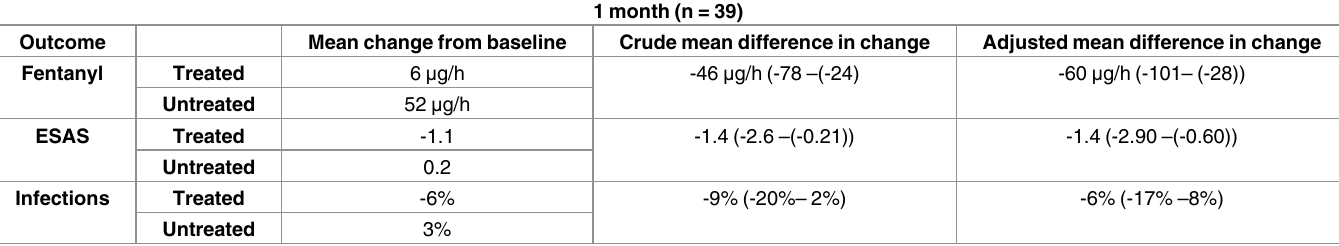
Opioid dose At baseline there was no statistically significant difference in opioid doses between the groups. The mean fentanyl dose in the vitamin D treated patients was 31 μg/h at inclusion (n = 39), 37μg/h after one month (n = 39) and 22 μg/h after three months (n = 26). In the control group the mean fentanyl dose increased from 43 μg/h at baseline (n = 39), to 95 μg/h after one month (n = 39), and 117 μg/h (n = 26) after three months observation time. The change in fentanyl dose between the groups was analyzed by linear regression with bias corrected and accelerated bootstrap and revealed a statistically significant difference already Table 2. Results from crude and adjusted analysis of change in fentanyl dose, ESAS QoL-score and infections (% days with antibiotics) compared to baseline in vitamin D treated and untreated patient after 1 month. Figures show mean value (95% CI). 1 month (n = 39) Outcome Mean change from baseline Crude mean difference in change Adjusted mean difference in change